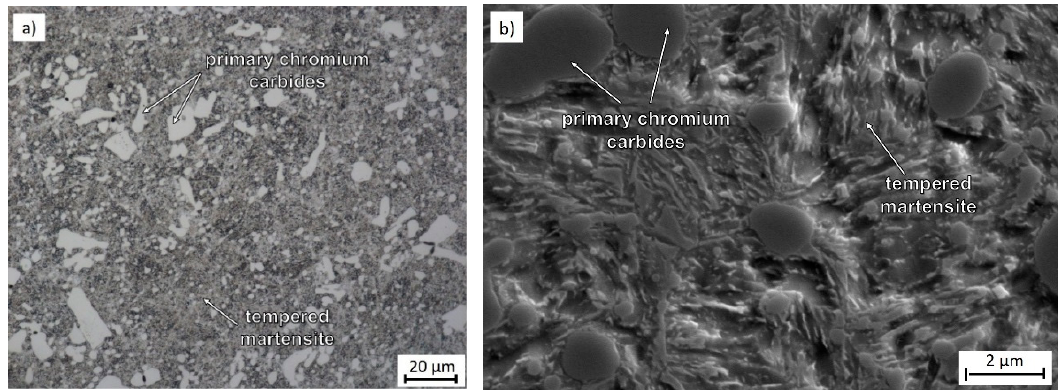
Figure 8. Regime 7—960 °C/oil–250 °C/60 min: a matrix of tempered martensite, spheroidised primary chromium carbides, and cementite, ( a ) optical micrograph; ( b ) detail scanning electron micrograph.